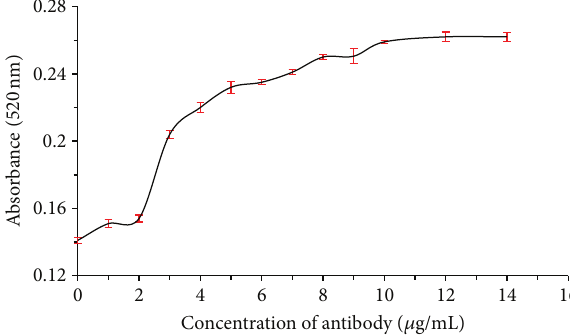
Figure 3: Determining the minimum protective amount of